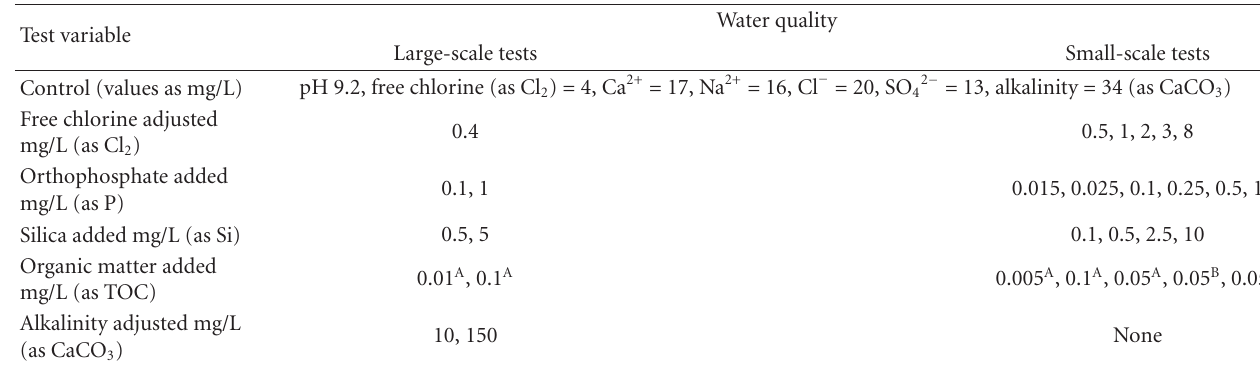
Table 2: Experimental conditions for large- and small-scale tests.